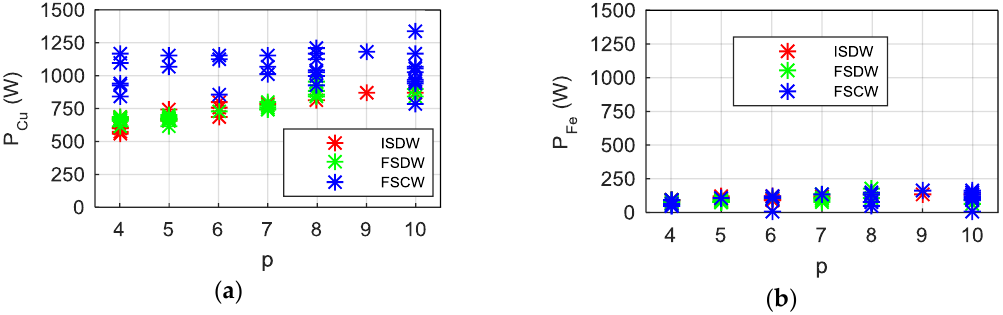
Figure 24. ( a ) Copper losses ( P Cu ); ( b ) and iron losses ( P Fe ) versus pole pair number ( p ) and winding type.